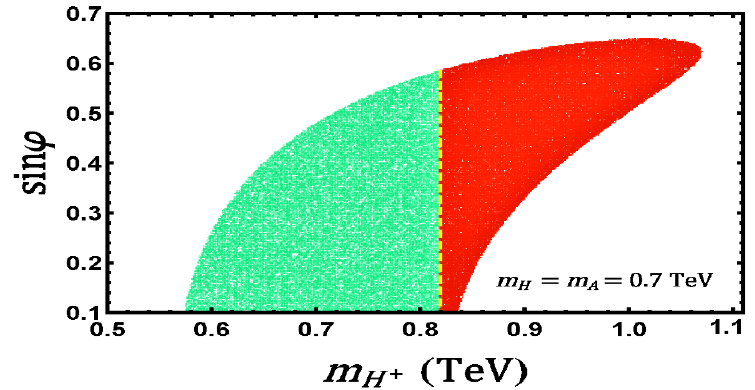
Figure 7 . T -parameter constraint in the mixing and heavy charged scalar mass plane in the Zee model for heavy neutral scalar masses m H = m A = 0 : 7 TeV. The colored regions (both green and red) are allowed by the T -parameter constraint, while in the red-shaded region, which we discard from perturbativity